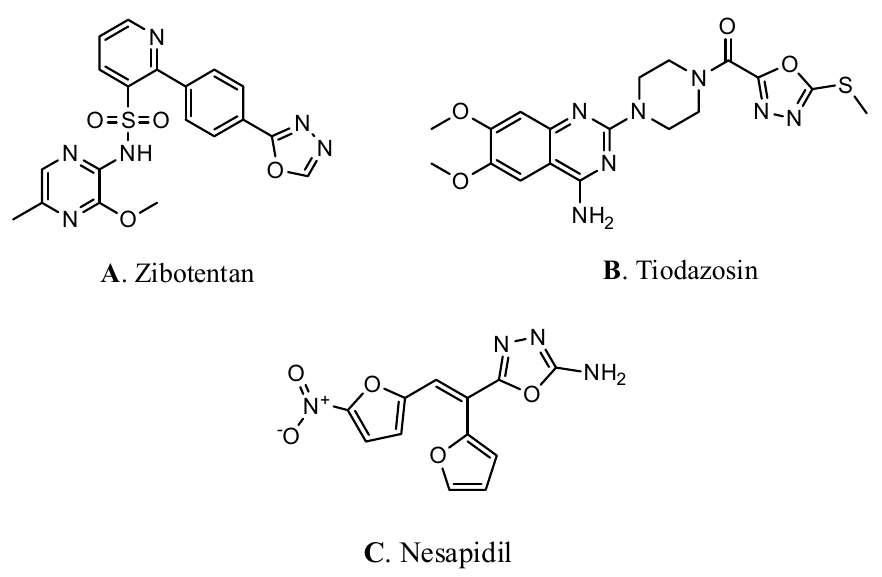
Figure 1. Already reported FDA approved oxadiazoles [14,15].